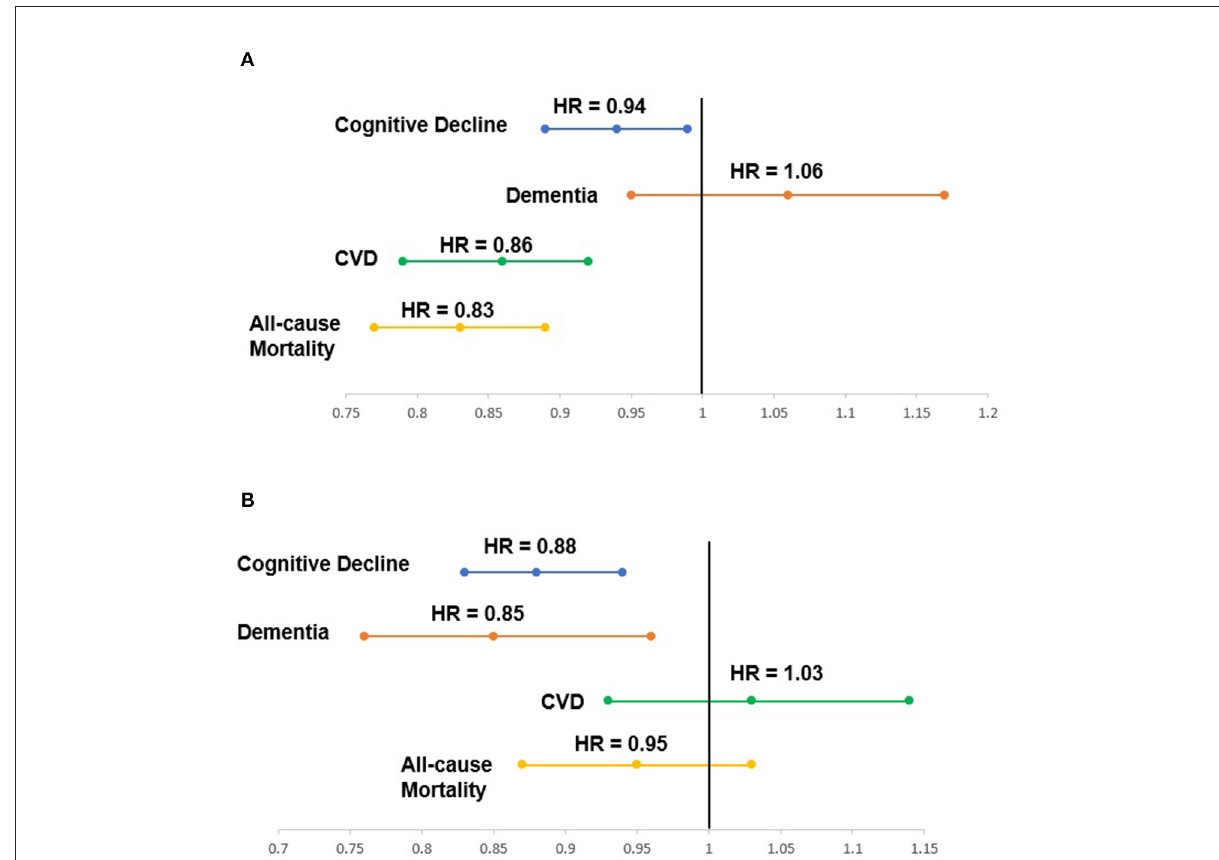
FIGURE1 (A) Association between physical health-related quality of life at baseline and the risk of health outcomes over a median of 4.7 years; (B) Association between mental health-related quality of life at baseline and the risk of health outcomes over a median of 4.7